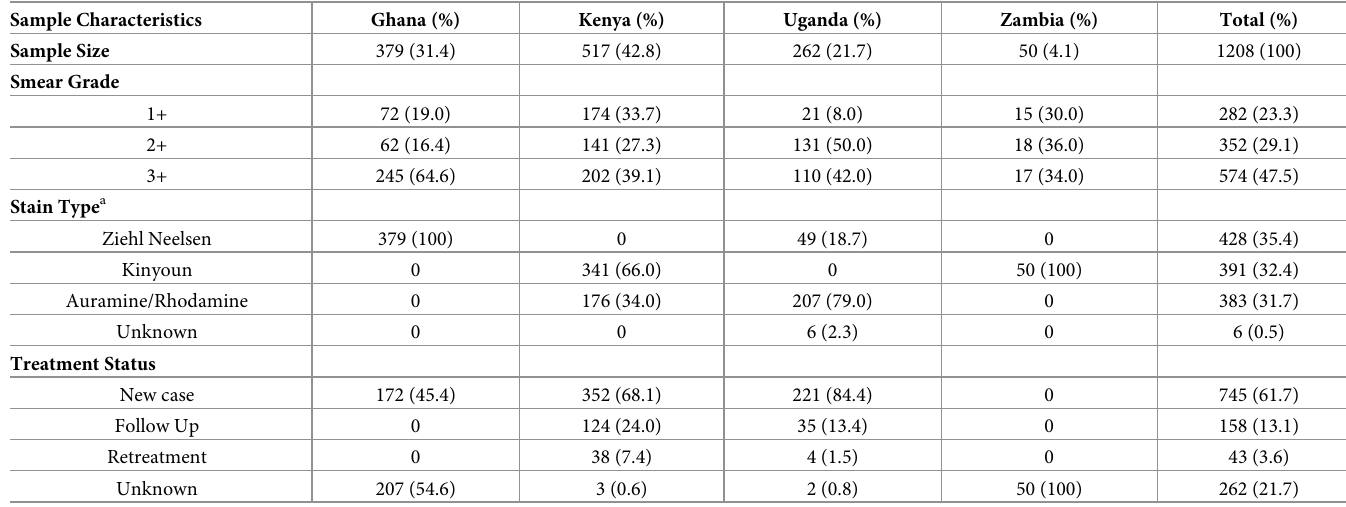
Table 2. Sample characteristics by